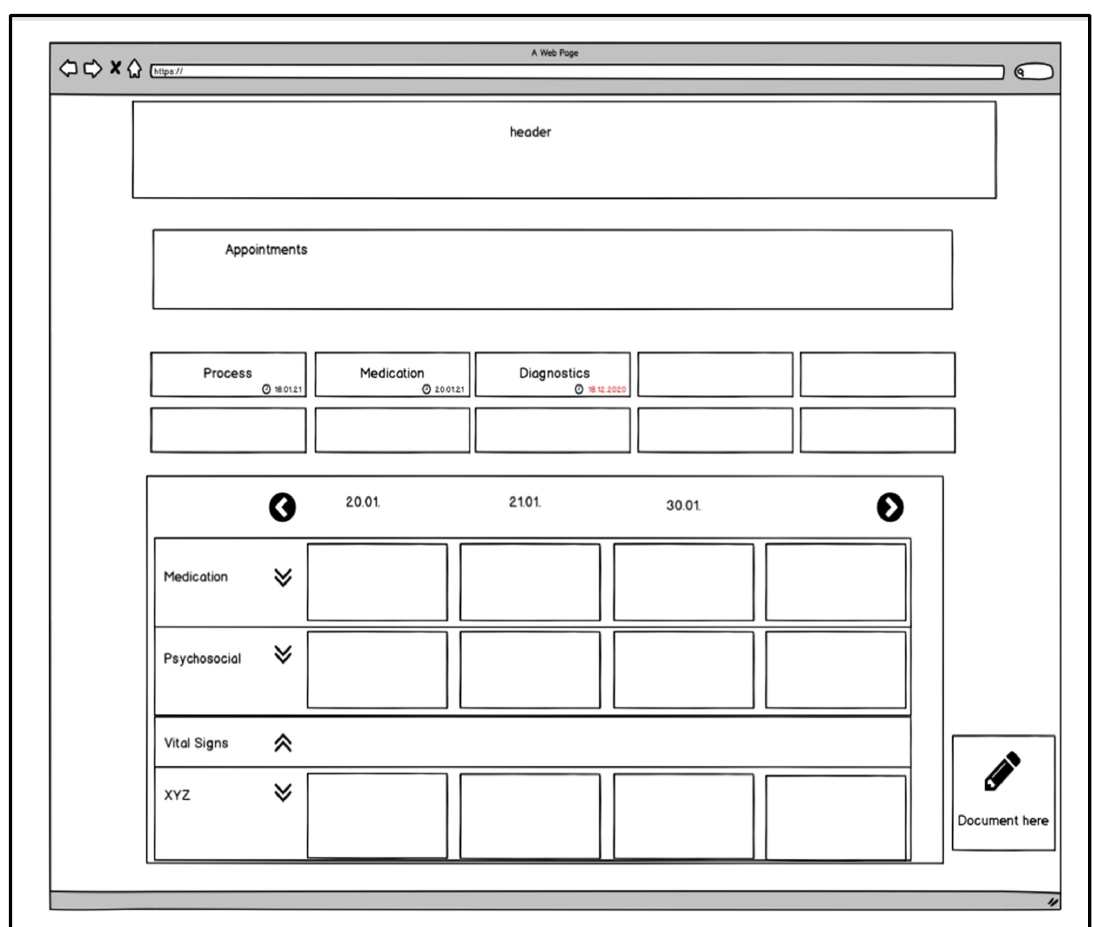
Figure 3. Idea for the patient main page (part of the developed mock-up).